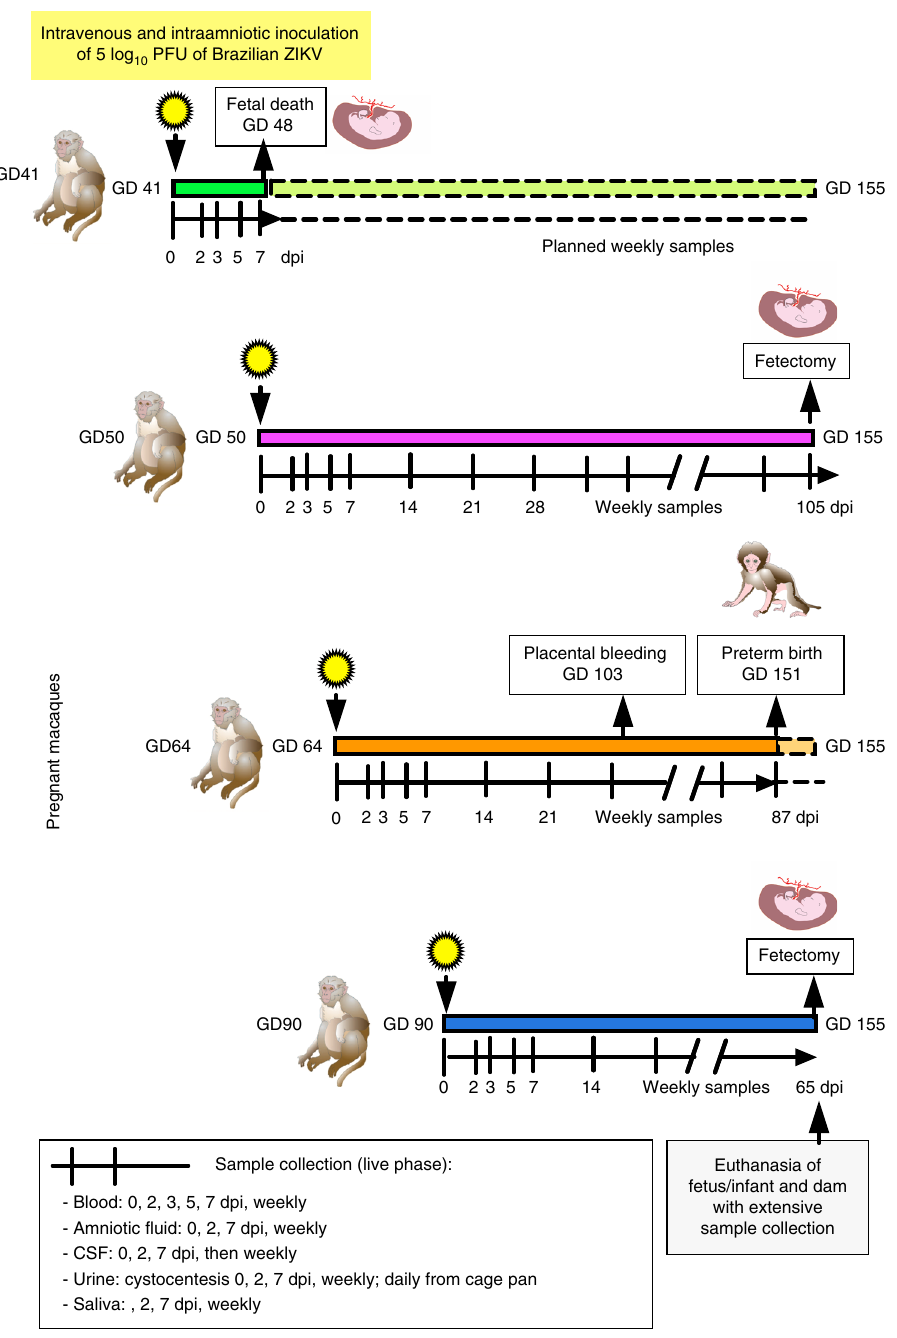
Fig. 1 Schematic experimental design showing infection and sampling timeline for the four pregnant rhesus macaques in the study. Pregnant macaques, identi fi ed by gestation day (GD) of inoculation, were intravenously (IV) and intraamniotically (IA) inoculated with 5 log 10 PFU of Brazilian ZIKV strain SPH/ 2015 in the fi rst or second trimester of pregnancy. Sample collection and ultrasound-monitoring schedules, originally intended until near term at GD155, are noted. CSF is cerebrospinal fl uid, dpi is days post inoculation. Animal color scheme is consistent for other fi gures. Not shown are the three GD-matched animals that were sham-inoculated and sampled on the same schedule as the ZIKV-inoculated